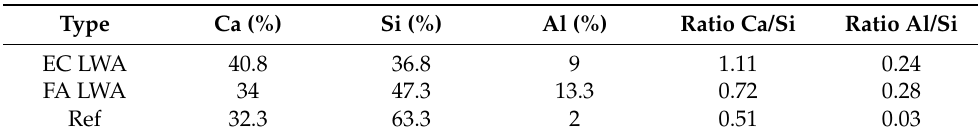
Table 4. Resume of EDS mapping analysis on the amount of Ca, Si and Al in ITZ between cement paste and